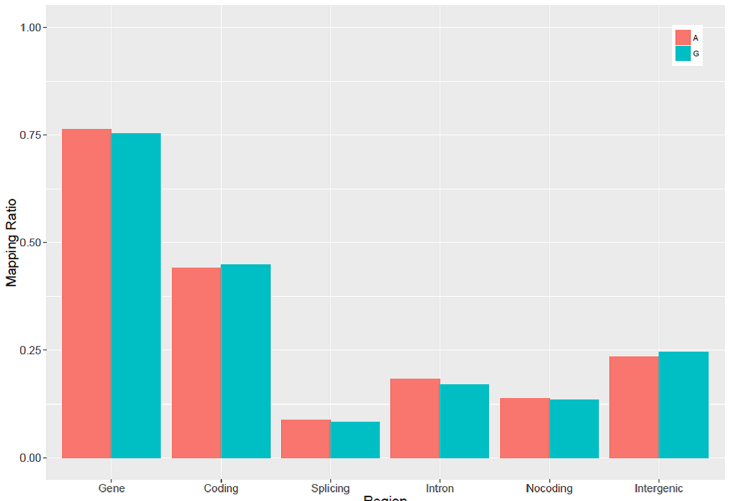
Fig 2. Distribution of the mapped reads on different regions of the chicken referencegenome. Noncodingregionsincludeall the 5 0 UTR, 3 0 UTR and other noncoding RNA regions. UTR = untranslated region.